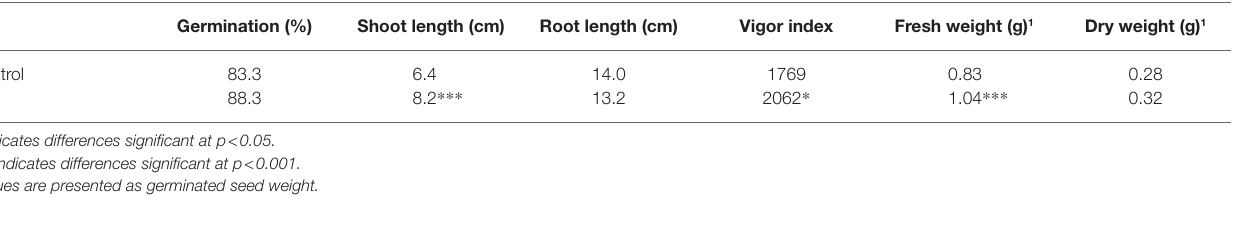
TABLE 1 | Effect of Mucilaginibacter sp. K on maize germination parameters.